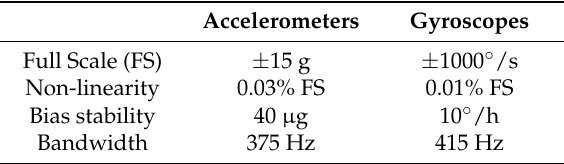
Table 1. Technical parameters of